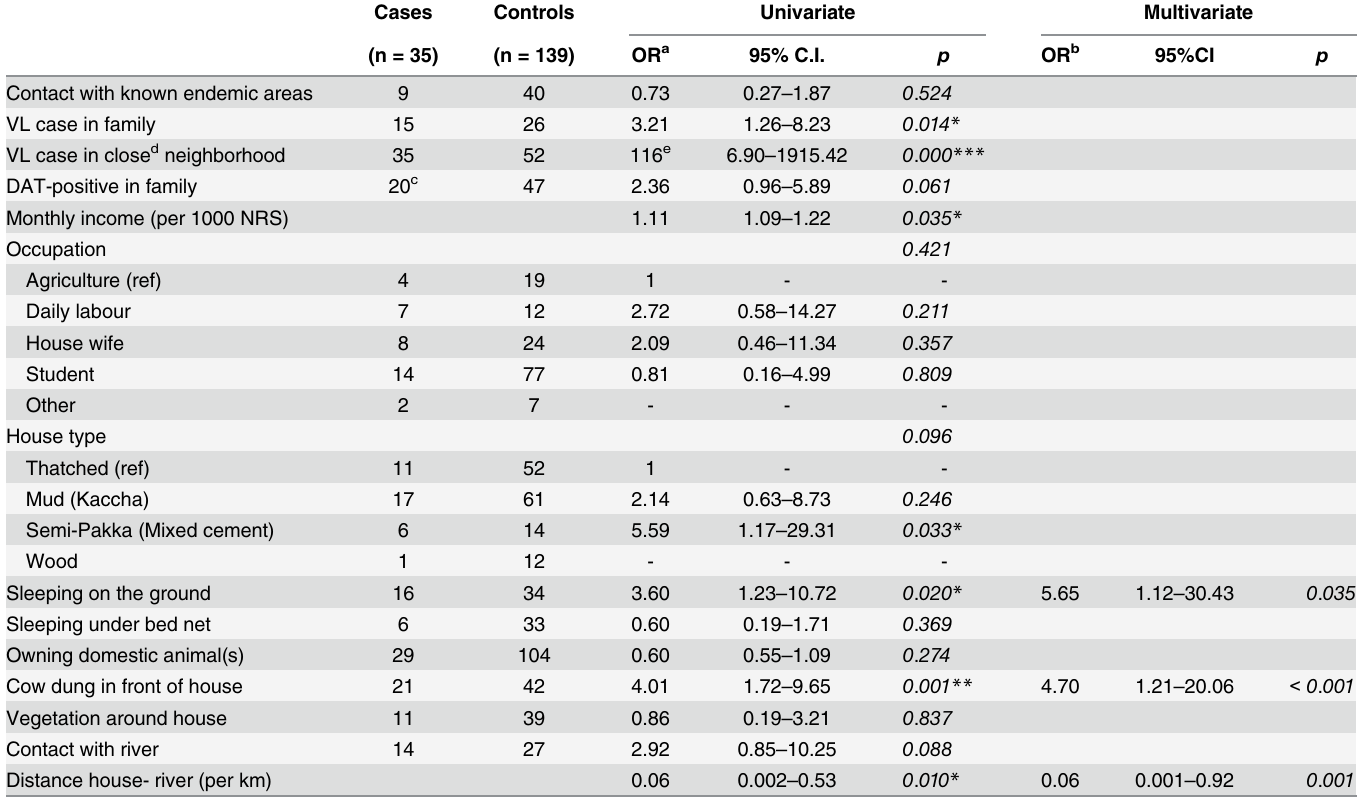
Table 3. Number of cases and controls with potential risk factors for KA, univariate Odds Ratios (OR) controlled for age, sex, village and adjusted OR obtained in final multivariate